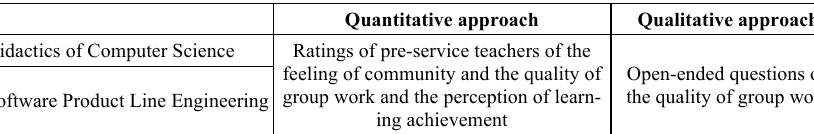
Table 1. Case study